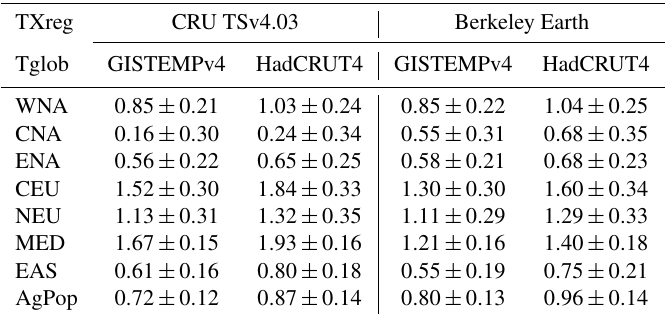
Table A1. Slopes for all possible combinations of the observational data sets used for the linear regression as well as their uncertainties (1 standard deviation). TXreg CRU